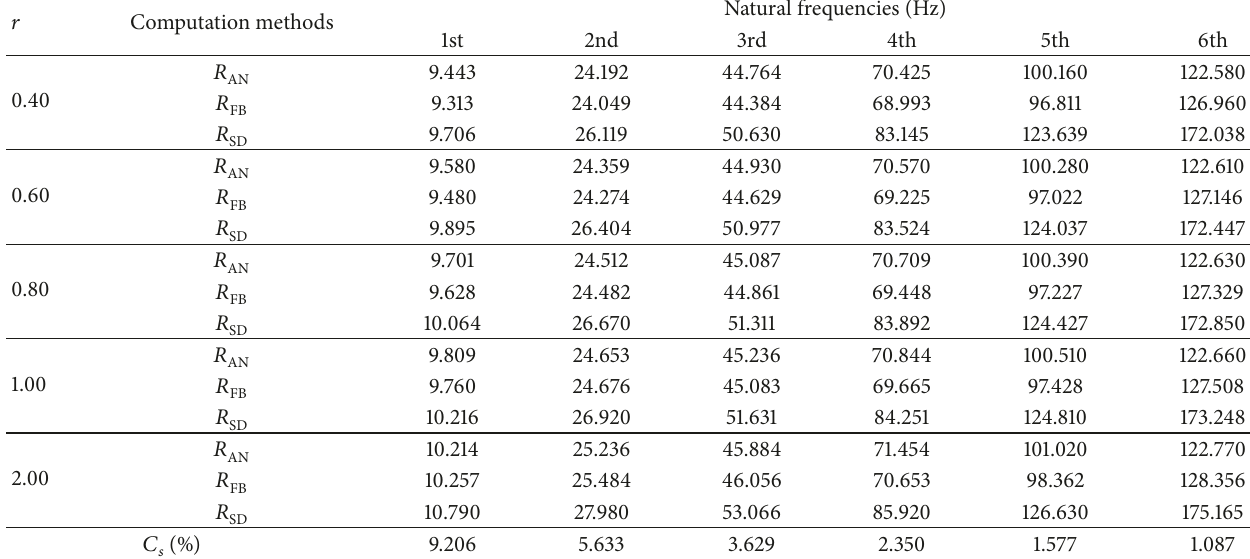
Table 1: Comparison of calculation results between the FBEM and ANSYS model (SCCTB-1).